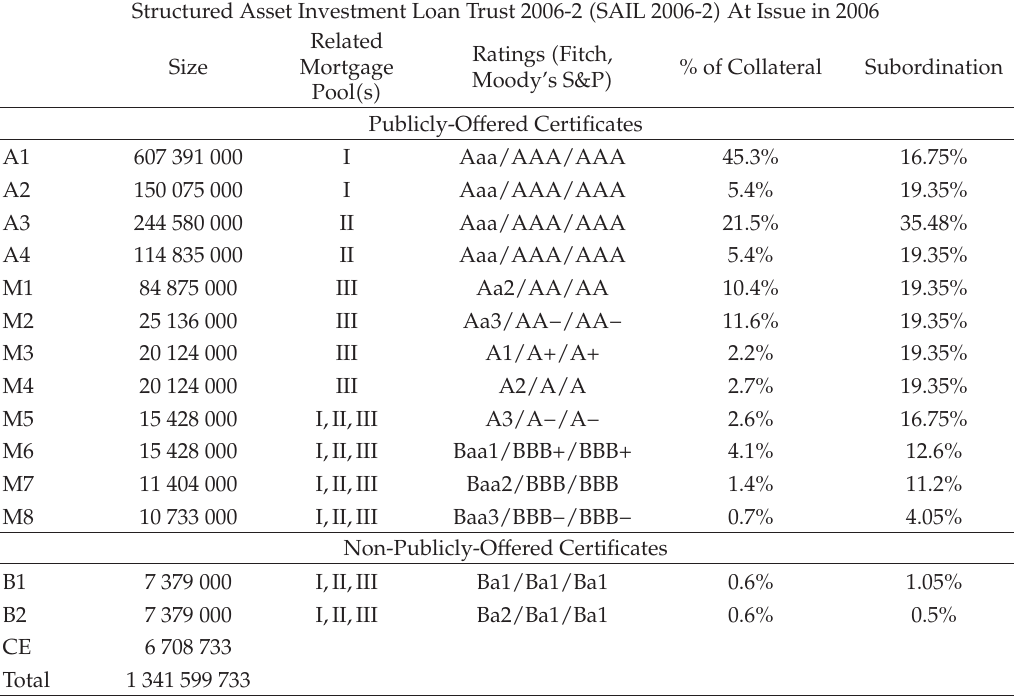
Table 10: Structured Asset Investment Loan Trust 2006-2 (cid:2) SAIL 2006-2 (cid:3) At Issue in 2006; Source: (cid:6) 25 (cid:7) .